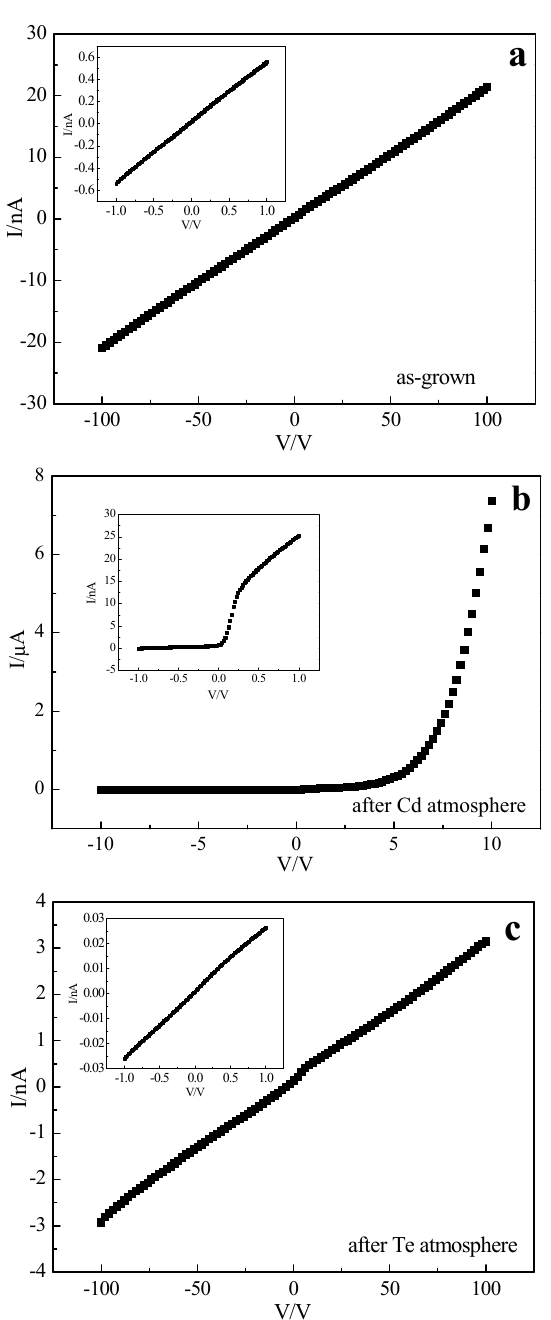
Figure 6. Current-voltage (I-V) curves of CMT:In crystals before and after annealing: ( a ) as-grown; ( b ) after Cd atmosphere; ( c ) after Te atmosphere. The inserts are the I-V curves ( − 1V~1V) of the crystals.